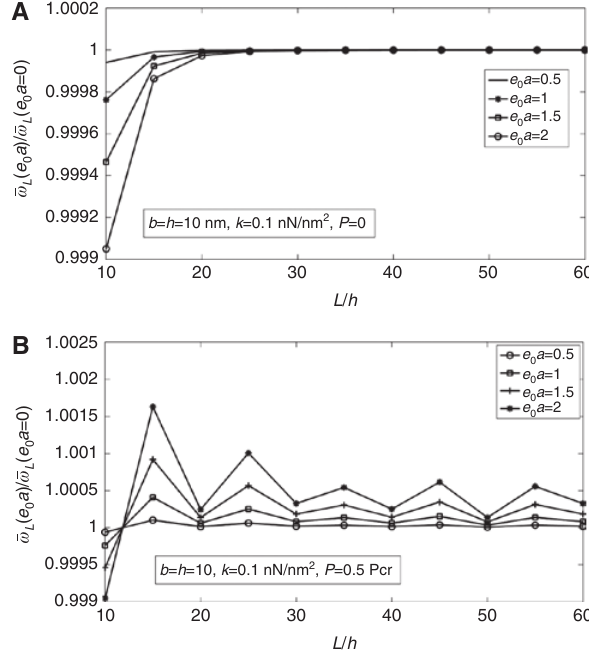
Figure 6: Effect of the increase of small scale on the fundamental frequency of FG nanobeams when preaxial force (A) is zero and (B) is not